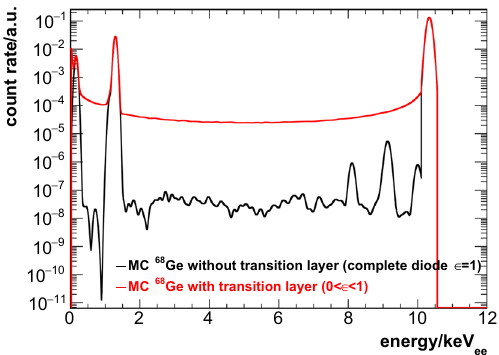
Fig. 5 MC simulation of the decay of 68 Ge within the C1 diode. The continuum between the lines is almost exclusively made up of slow pulses that were created in the transition layer. This is confirmed by the black spectrum, for which neither the transition nor the dead layer was included in the post-processing of the MC, and consequently there is nearly no continuum between the